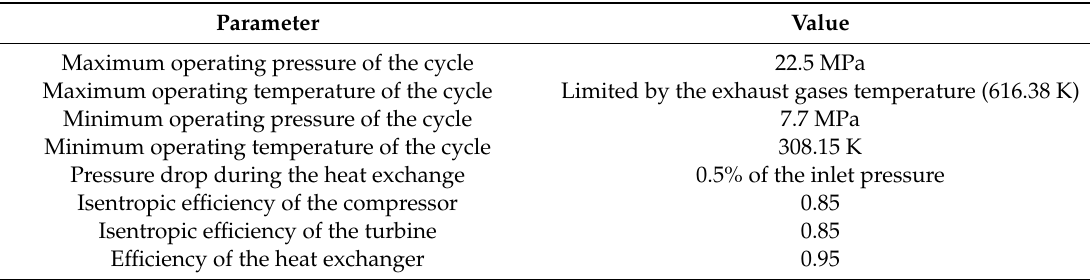
Table 2. Assumptions and constraints of S-CO 2